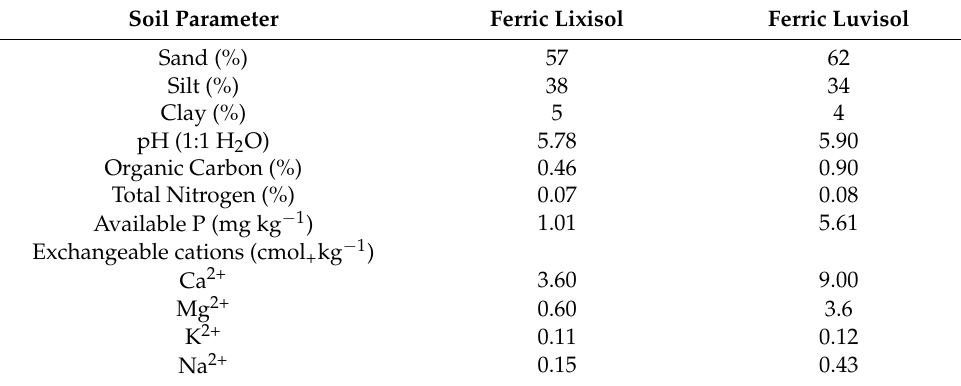
Table 1. Initial soil physical and chemical properties of the experimental